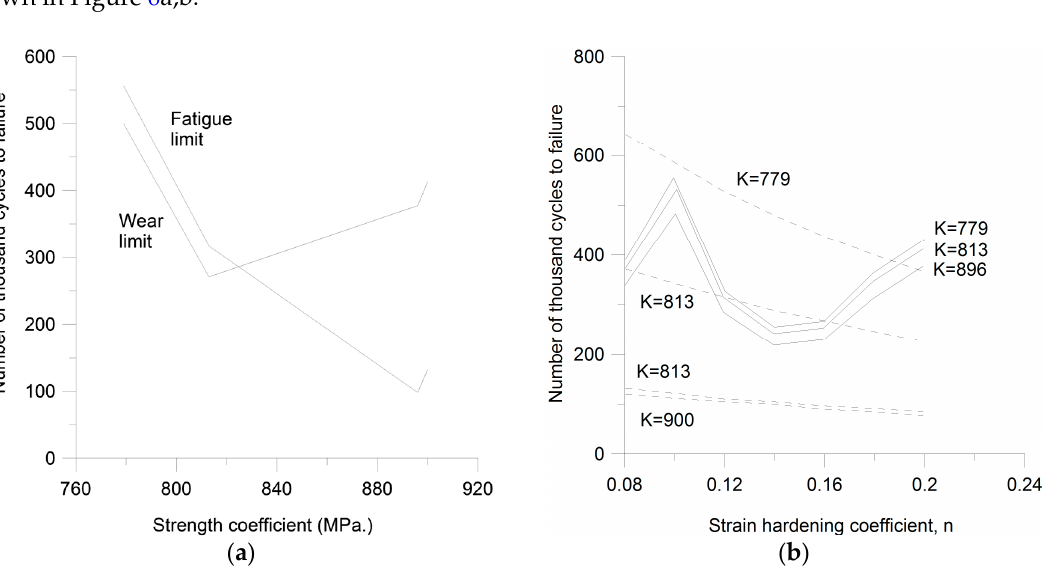
Figure 6. ( a ) Simulated fatigue and wear life versus strength coefficient after ref. [16]; ( b ) Simulated fatigue life for four different strengths coefficients versus the strain hardening coefficient after ref. [16]. Dashed line = fatigue limit, solid line = wear limit.